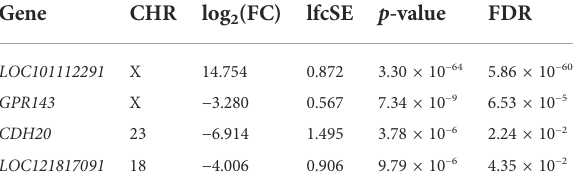
TABLE 1 Differentially expressed genes (|log 2 (fold-change)| > 2 and FDR < 0.05) between males and females in the perirenal fat of Assaf suckling